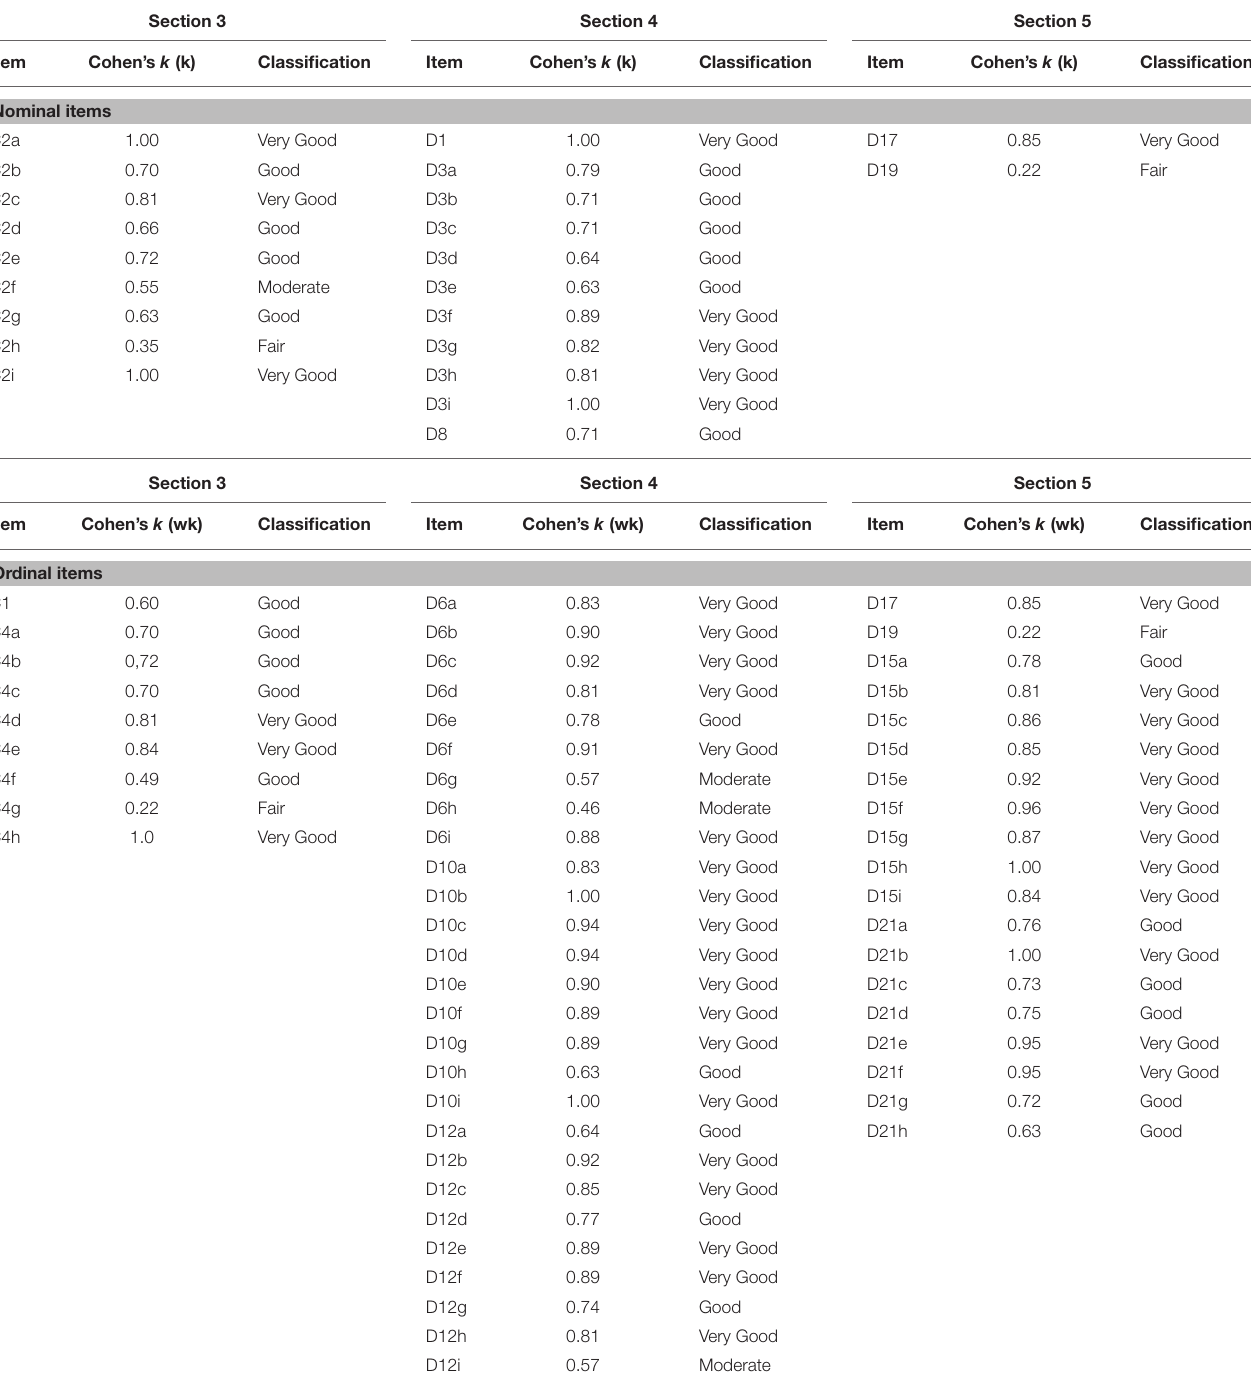
TABLE 2 | Reliability outcomes for nominal and ordinal items derived from the questions of the